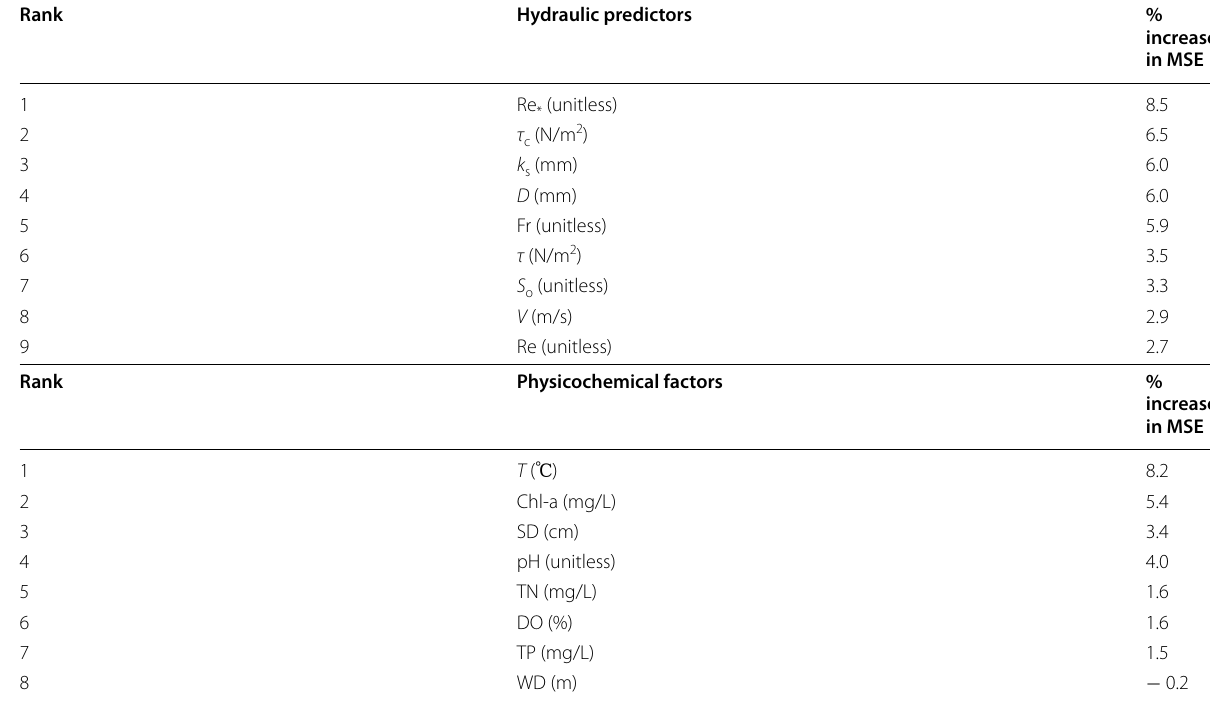
Table 4 Random forest importance ranking of four habitat hydraulic variables and physicochemical factors on freshwater mussel density in Poyang